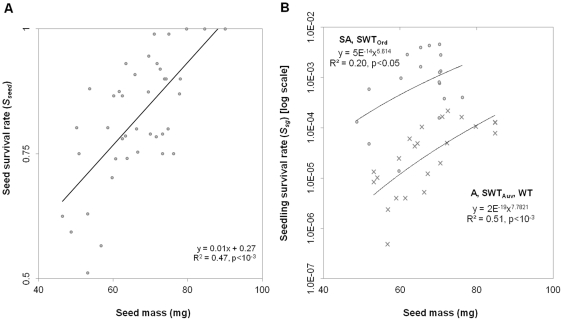
Benefits of plasticity on fitness components.A) on seed survival rate (Sseed), and B) on seedling survival rate (Ssg). A, SA, SWT, WT refer to the climate regions (see nomenclature in Fig. 1). For SWT, the Ord site (SWTOrd) and Auvergne site (SWTAuv) were analysed separately to account for the difference in Ssg.